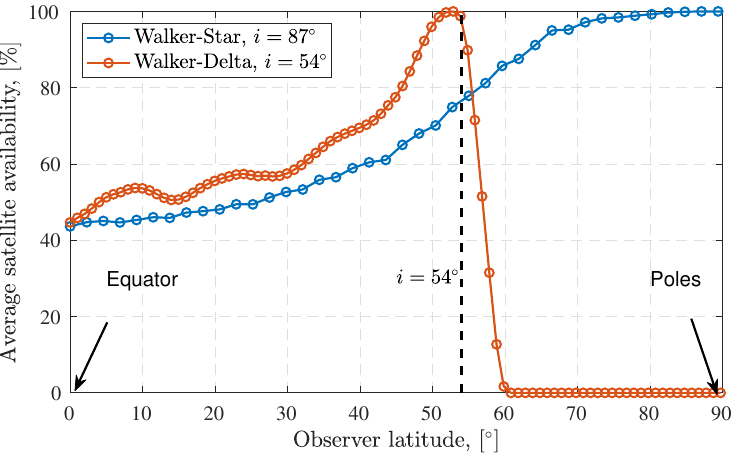
Figure 5. An example of the average satellite availability for variable ground device latitudes with N s = 480 and h = 550 km. The satellite antenna beamwidth is set to 80 ◦ whereas the remaining constellation parameters considered are summarized in Table